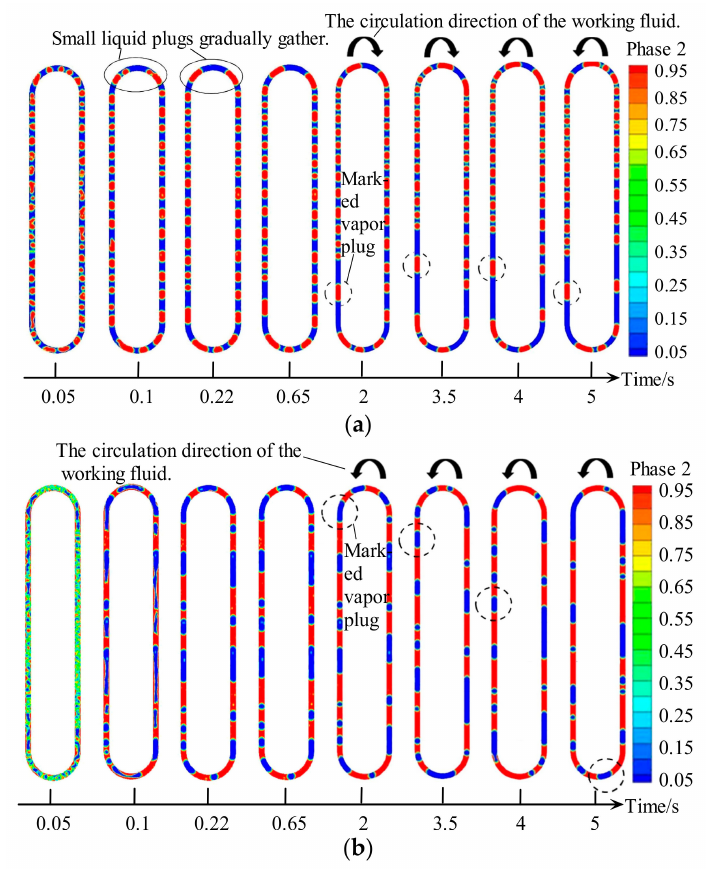
Figure 10. Volume fraction of liquid and vapor at heat load 20 W [165]. Wang et al., (2020). ( a ) Volume fraction of liquid and vapor at heat load 20 W and contact angle 147 ◦ . ( b ) Volume fraction of liquid and vapor at heat load 20 W and contact angle 33 ◦